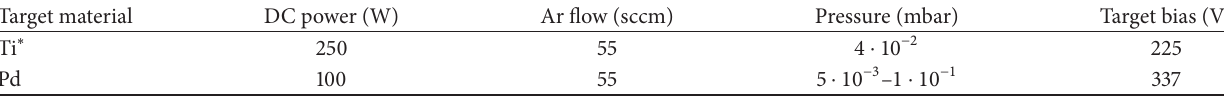
Table 1: Sputter parameters for the investigated Pd layers.